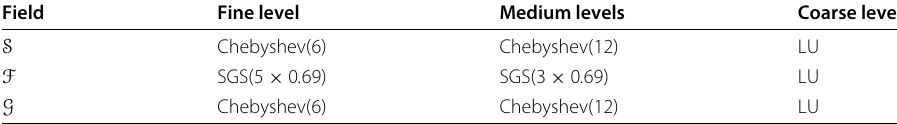
Table6 Settings for multigrid hierarchies embedded in the hybrid preconditioner Field